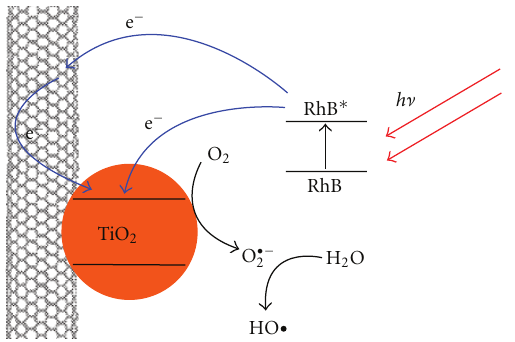
Scheme 1: Schematic diagram representing the charge-transfer process in CNT/TiO 2